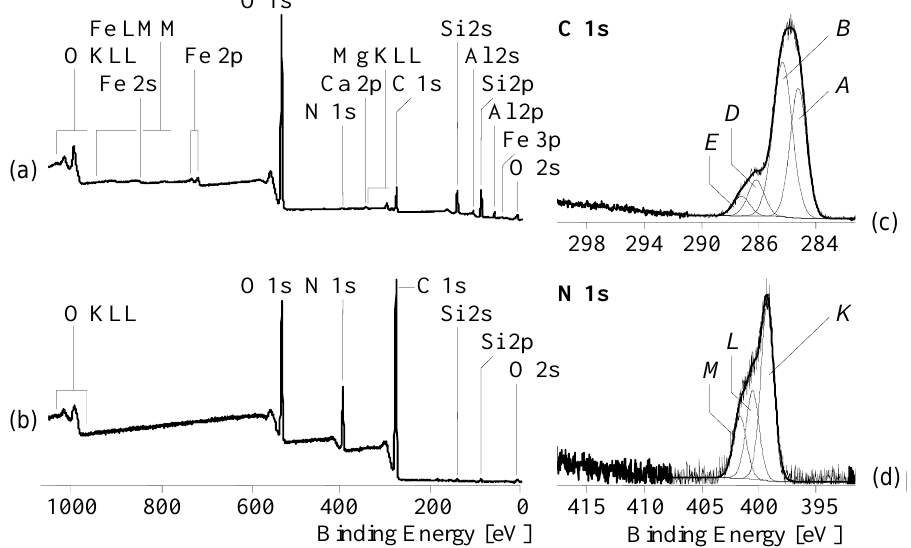
Figure 4. XPS survey spectra of unmodified F100 sand fraction ( a ) and F100/(PEI 2 /PAA 1 )-GA 1:10 composite ( b ) and XPS high resolution spectra of C 1s ( c ) and N 1s ( d ) obtained for the same composite surface.